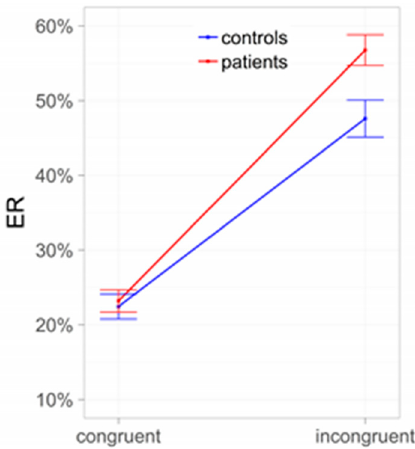
Figure 2. Conflict between Pavlovian and instrumental control: Subjects with alcohol use disorder (AUD) compared to controls. ER = error rates.